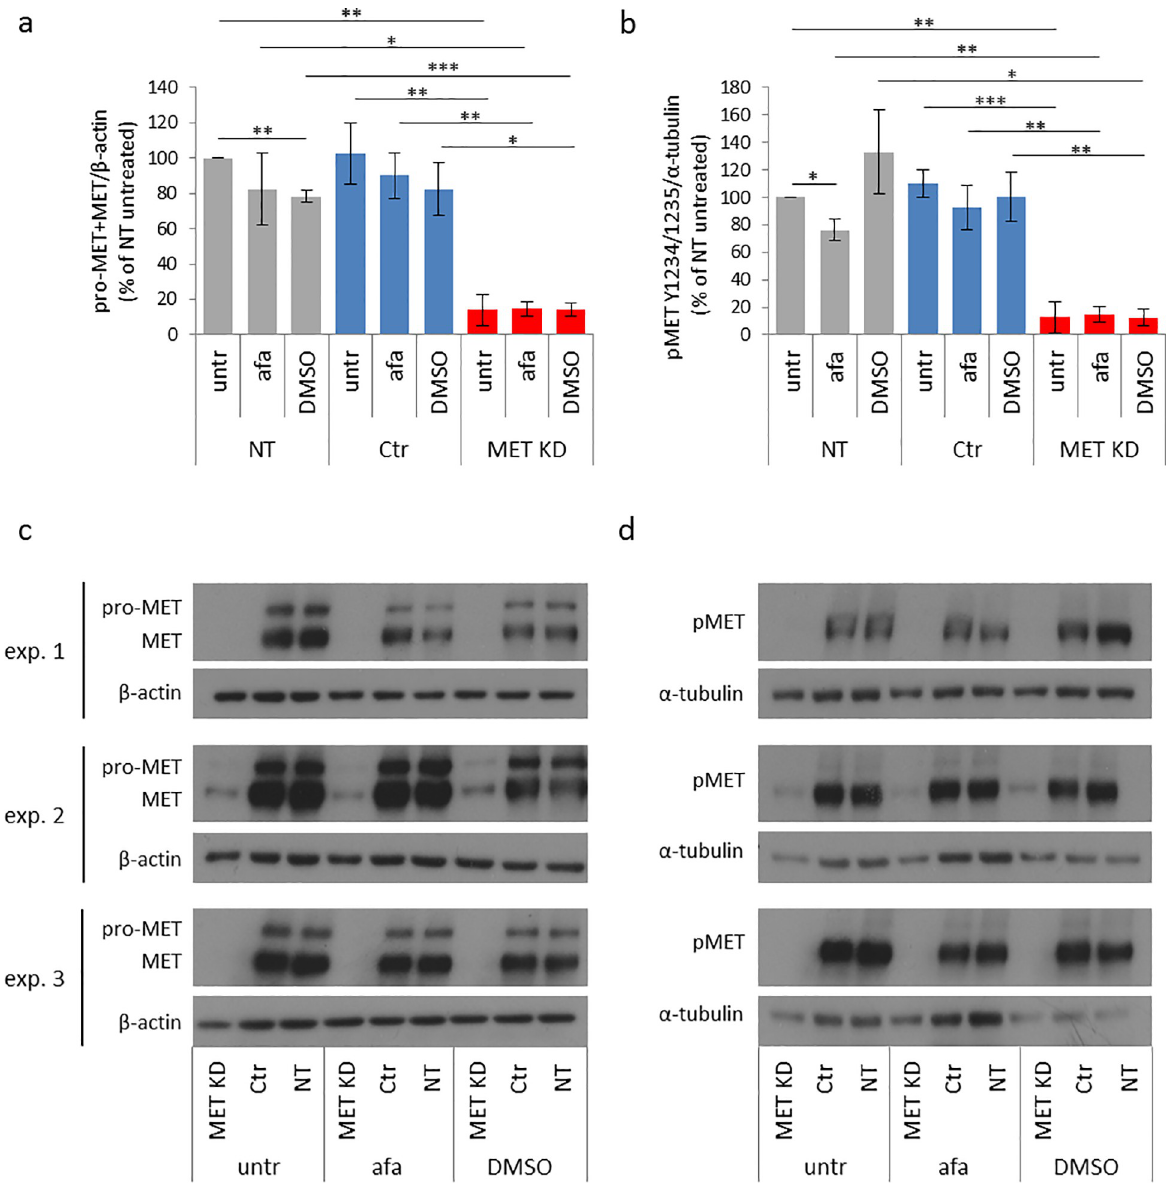
Fig 2. MET knockdown decreases MET expression and activation. Hs746T cells were transfected with MET siRNA (MET KD) or control siRNA (Ctr). Non-transfected cells (NT) were analyzed in parallel. Two days after transfection, cells were treated with 0.5 μ M afatinib or 0.05% DMSO (solvent control) for 20 minutes. Cell lysates were analyzed by Western blot with antibodies against MET (a) and pMET Y1234/1235 (b). The MET antibody recognizes mature MET and its precursor pro-MET. The mean of three biological experiments with standard deviation is shown. T-test was used to compare afatinib-treated, DMSO-treated and untreated cells within each group (NT, Ctr, MET KD) and to compare the untreated, afatinib treated and DMSO treated cells between the groups. Statistically significant differences are indicated by � p < 0.05, �� p < 0.01 or ��� p < 0.001. The corresponding Western blots for MET (c) and pMET Y1234/1235 (d) are